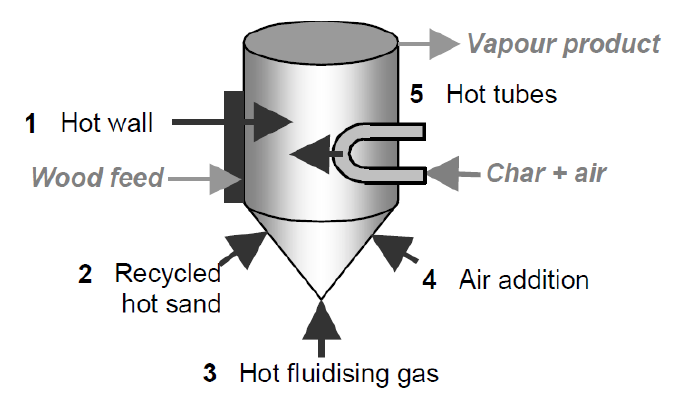
Figure 6. Methods of heat transfer to a pyrolysis reactor